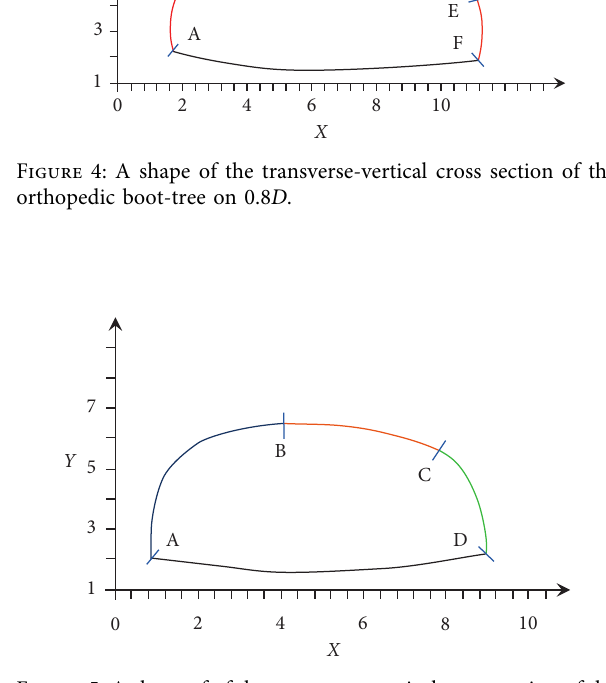
Figure 5: A shape of of the transverse-vertical cross section of the orthopedic boot-tree on 0.9 D .